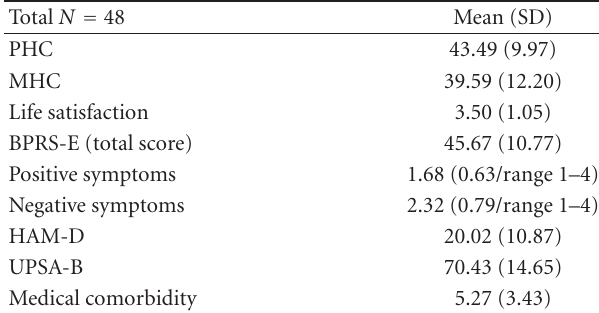
Table 1: Descriptive characteristics of the sample. Table 2: Means and standard